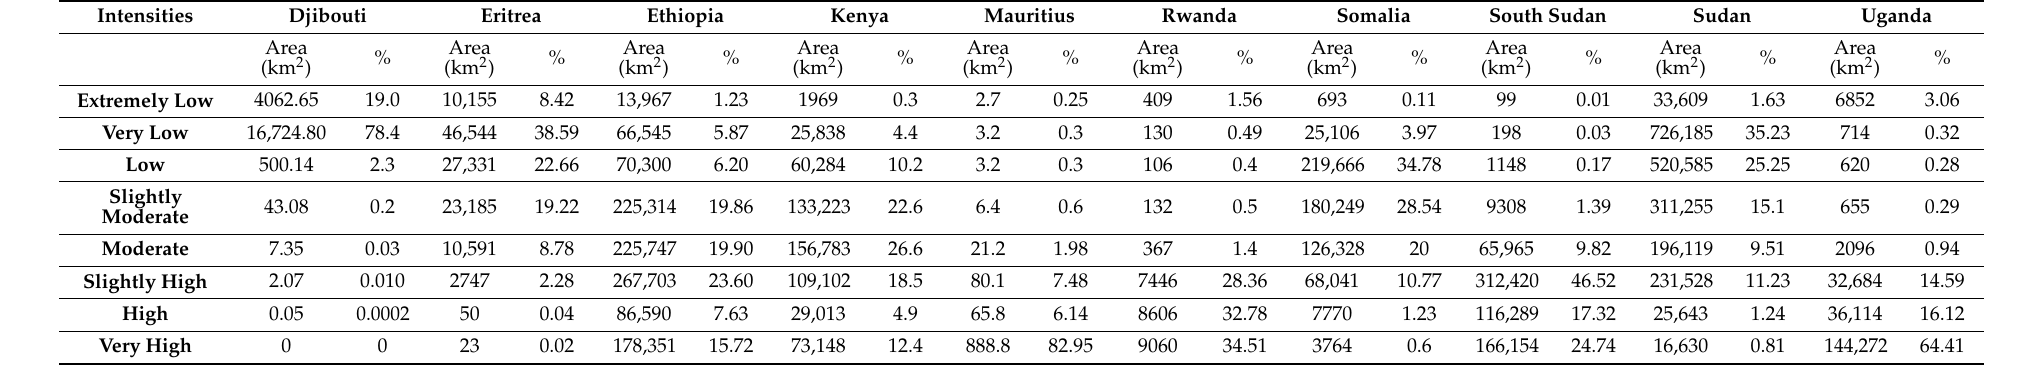
Table 16. Country specific status of land productivity for the studied countries as per